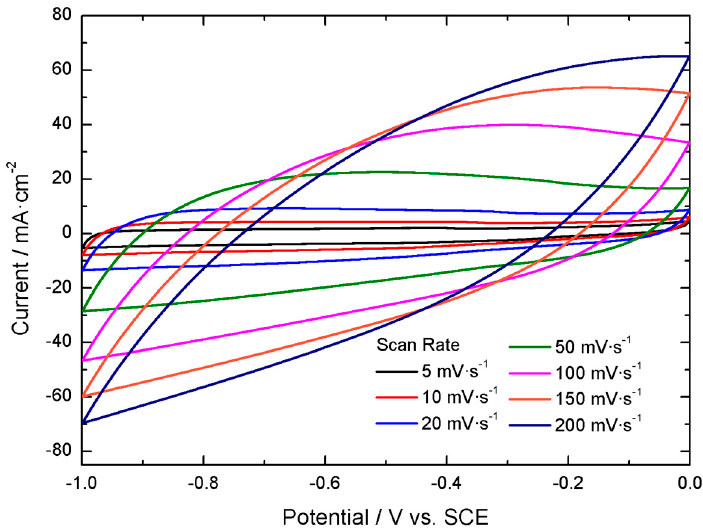
Figure 7. Cyclic voltammetry results obtained for YEC-8A in KOH 6M at different scan rates in the 0.0 V to − 1.0 V vs. SCE interval.